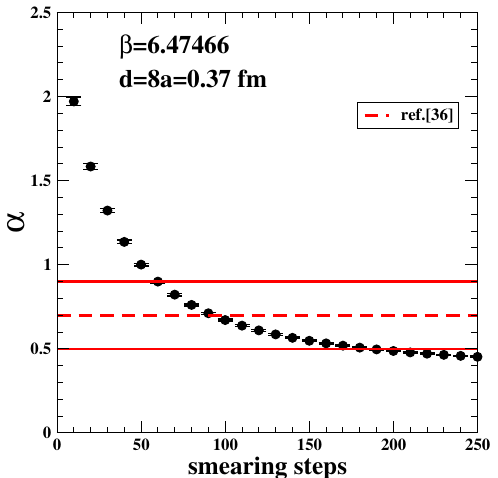
Fig. 10 The Clem α parameter (full black circles) versus smearing at β = 6 . 47466 and d = 8 a (cid:9) 0 . 37 fm compared to the value obtained x have been in Ref. [36] (the red dashed line is the central value, the red full lines delimit the error band)